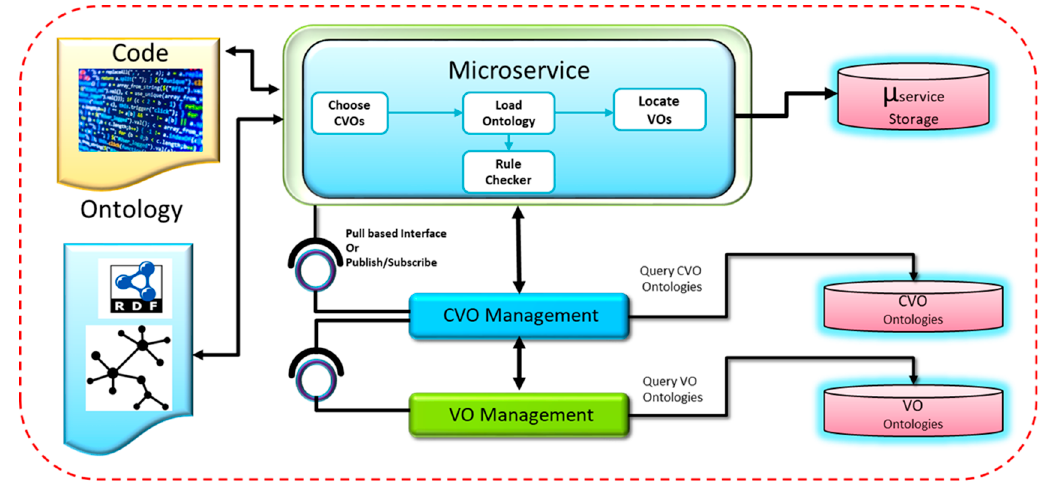
Figure 9. Design of microservice with Web Objects.